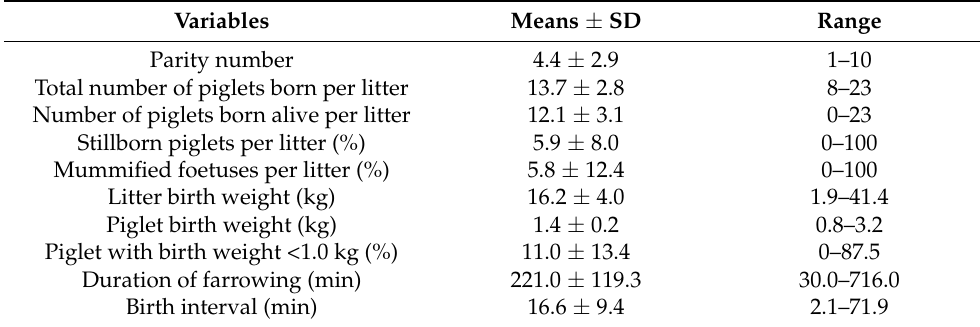
Table 1. Descriptive statistics on reproductive performance and farrowing characteristics of 2493 Landrace x Yorkshire cross-bred sows in a commercial swine herd in Thailand.